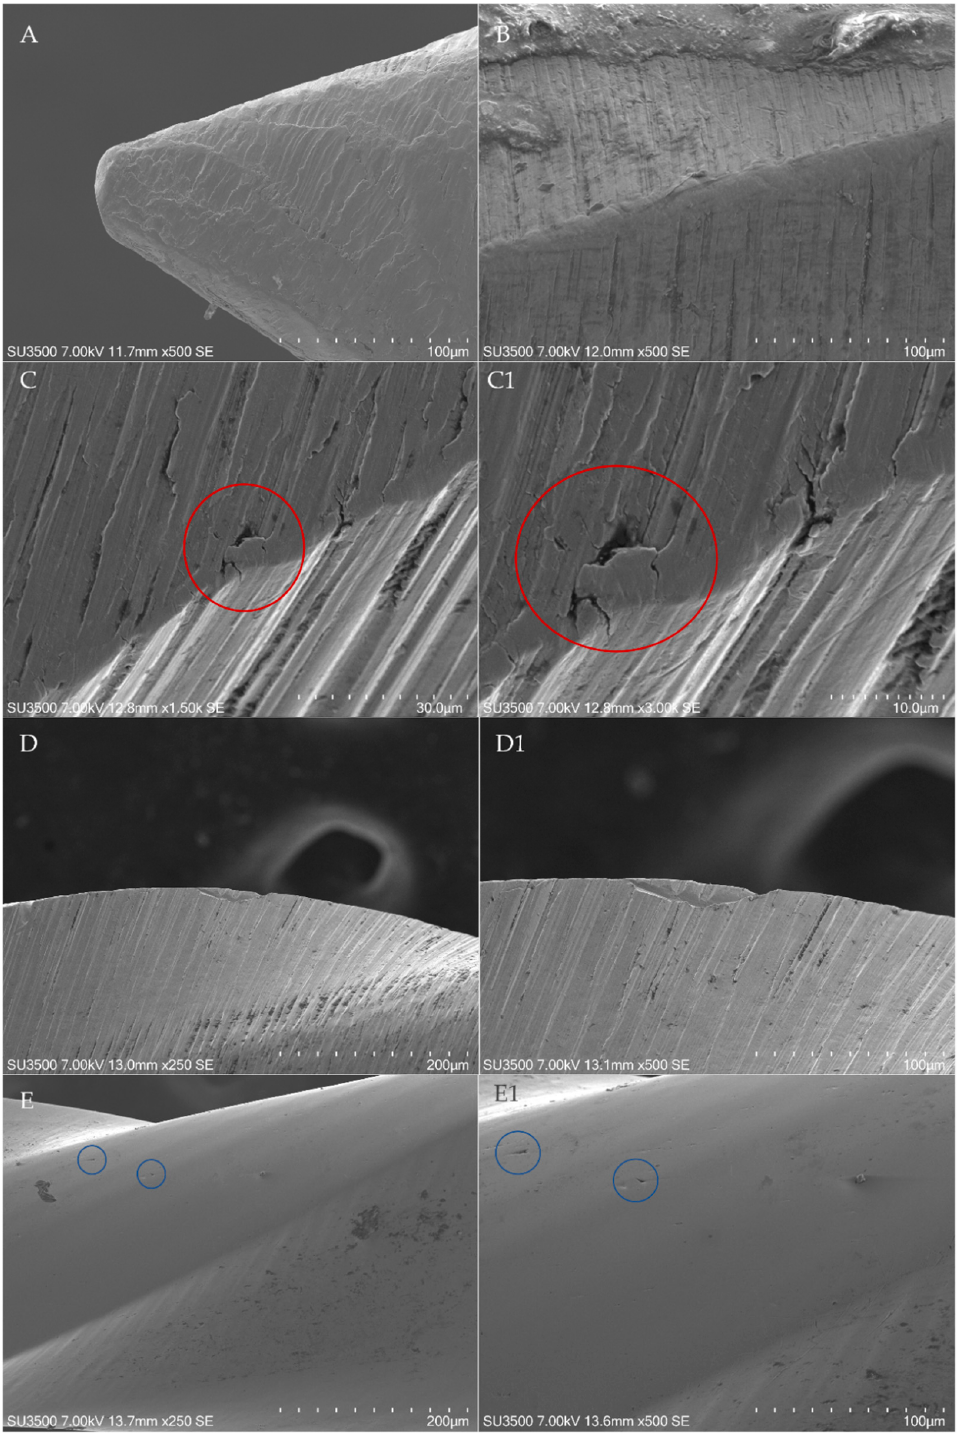
Figure 10. SEM micrographs of metal defects, microfractures and pitting of the 4 used brand instruments at different magnifications. ( A ) tip of a used EOF instrument, in which some grooves and metals defect can be noted at ×500 magnification. ( B ) EOF used instrument, in which some grooves and metals defect can be noted at ×500 magnification. ( C , C1 ) microfractures (red circles) noted on the cutting edge of a used WOG instrument at two different magnifications, respectively, ×1500 and ×3000. ( D , D1 ) sever disruption of the cutting edge of a used R25 Blue instrument with the association of microfractures (×250 and ×500 magnifications). ( E , E1 ) pittings showed on a used OR surface at two different magnification ×250 and ×500 (blue circles).